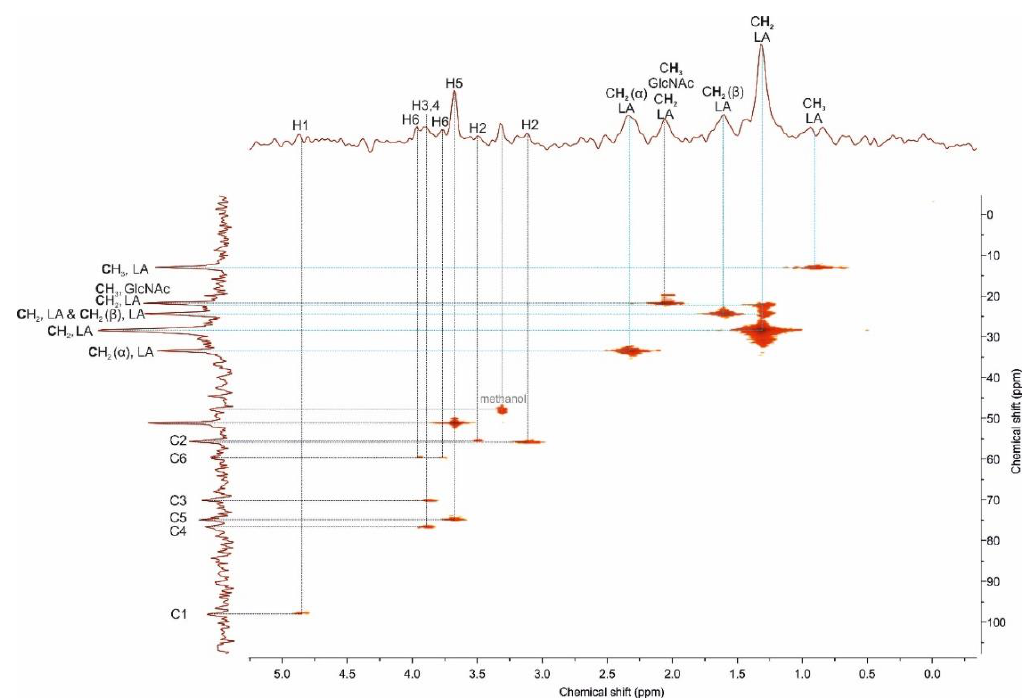
Figure 5. 1 H– 13 C HMQC spectrum of the chitosan derivative 2a. Figure 5. 1 H – 13 C HMQC spectrum of the chitosan derivative 2a.